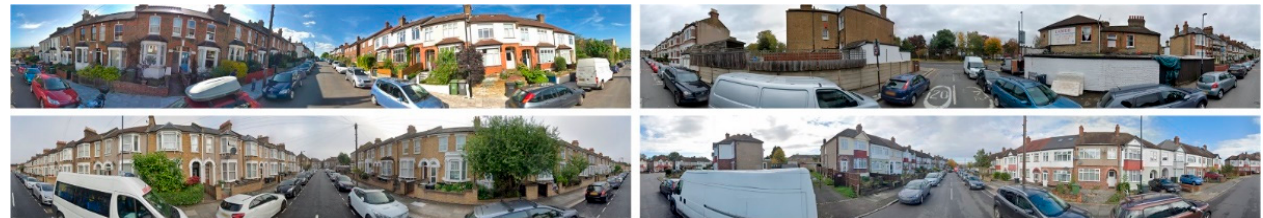
Figure 12. Residential streets are often occupied by many residents’ cars in Inner London. Question 3: How do micro ‐ scale streetscape features complement or conflict with macro ‐ scale built environment indexes?